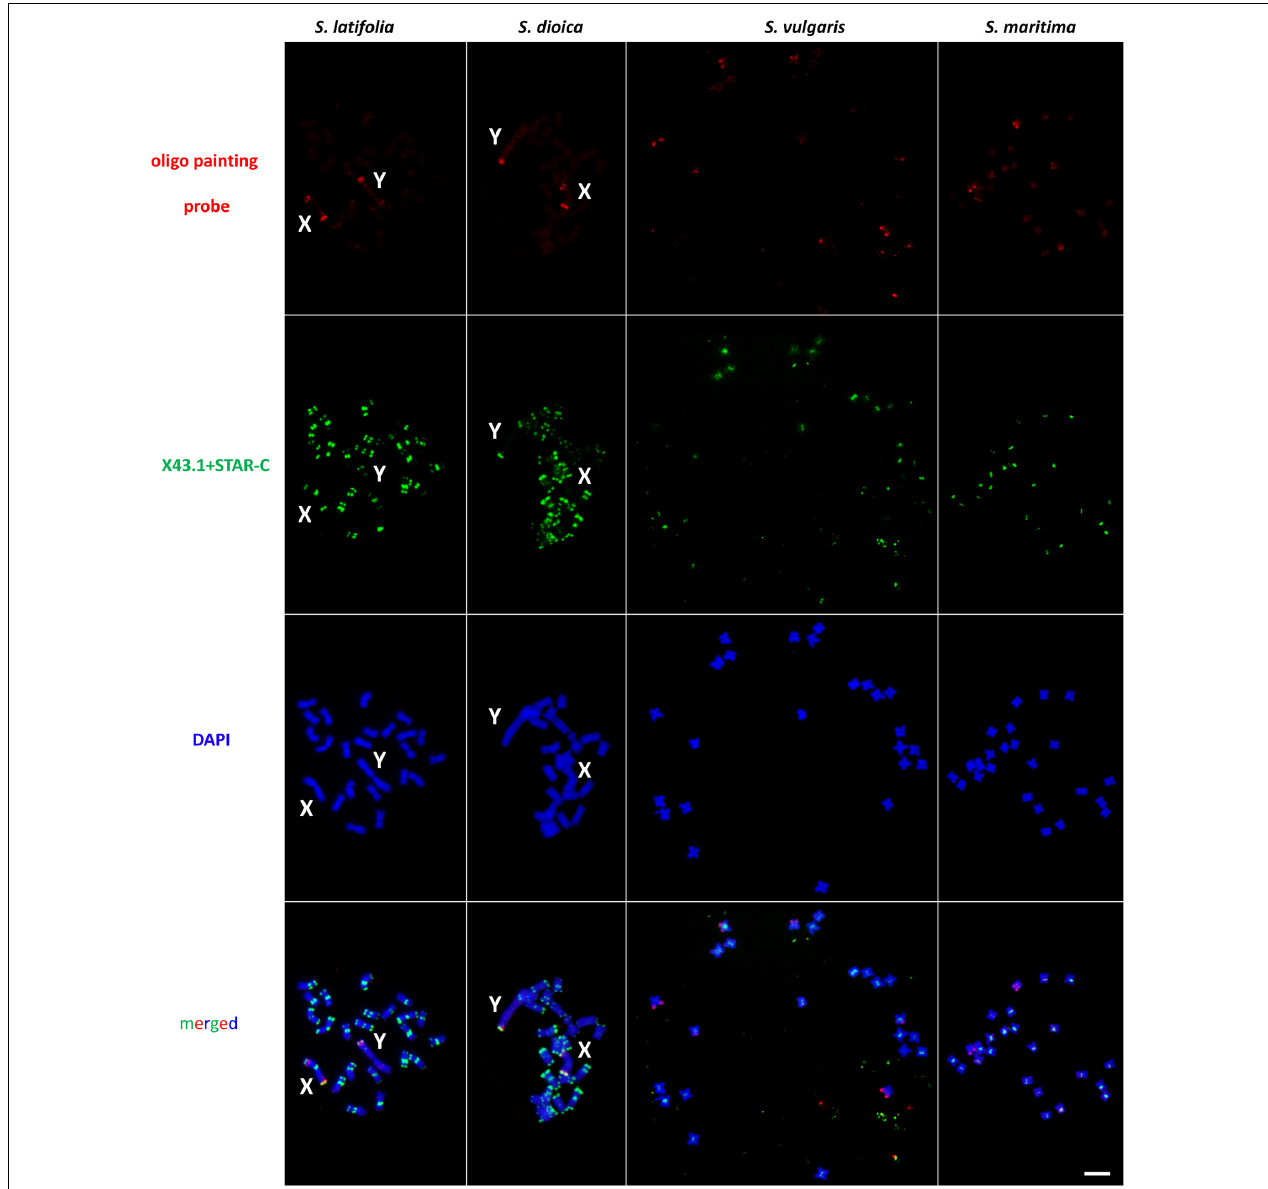
FIGURE 1 | Distribution of X chromosome-specific oligo probe on chromosomes in Silene latifolia , S. dioica , S. vulgaris and S. maritima . In S. latifolia and S. dioica , oligo painting probe has discrete signal only on X and Y chromosomes. In S. vulgaris and S. maritima , three pairs of autosomes can be differentiated from the whole genome. Scale bar = 5 µ